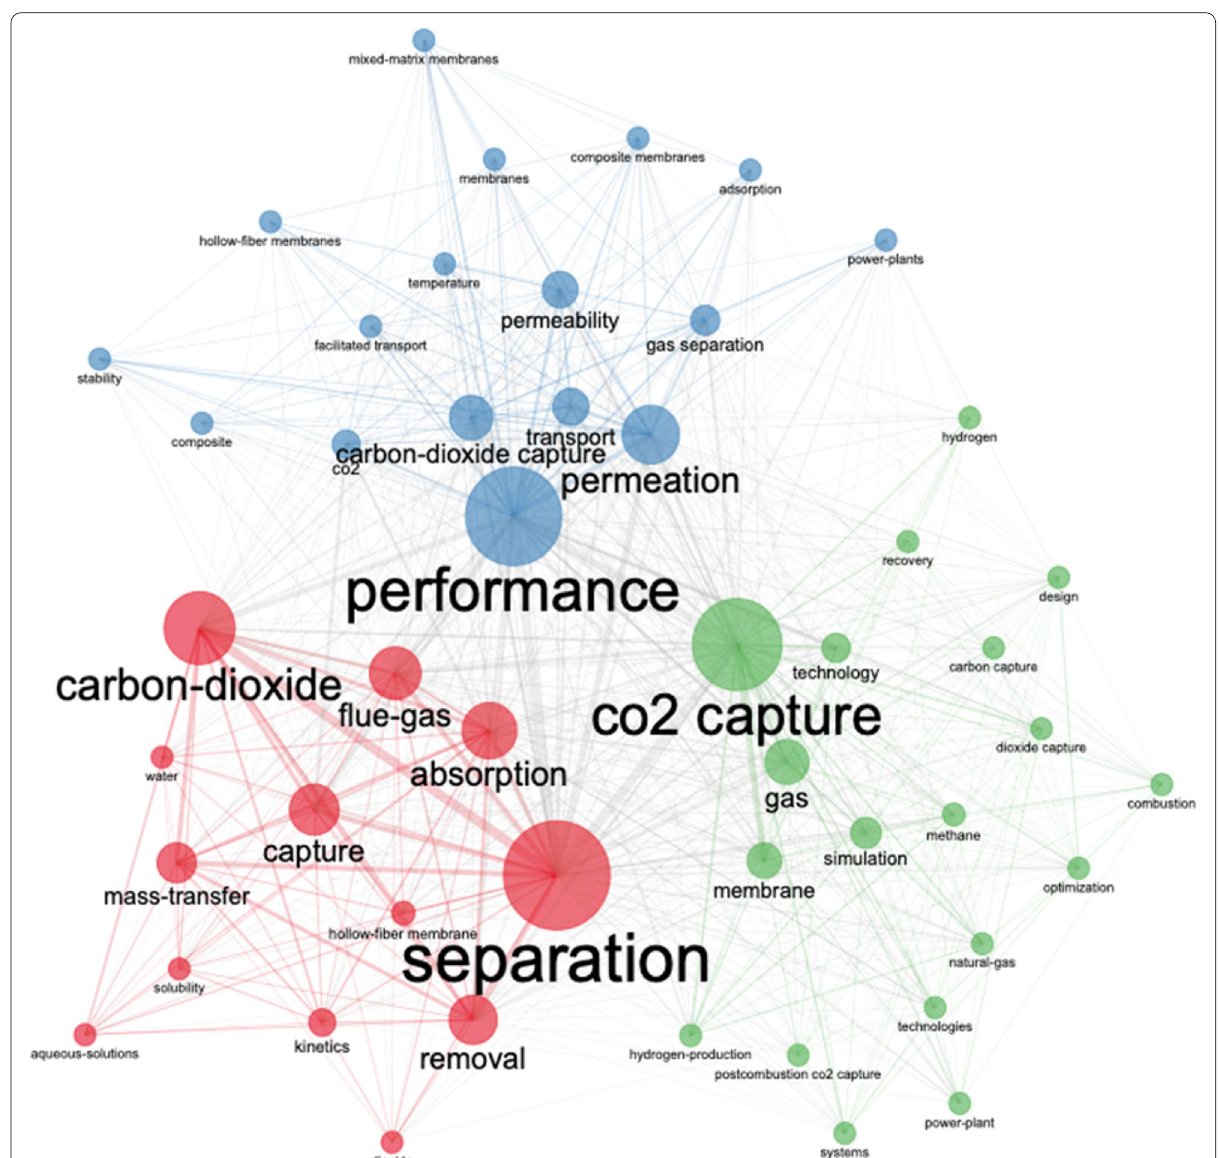
Fig. 52 Membrane, keyword